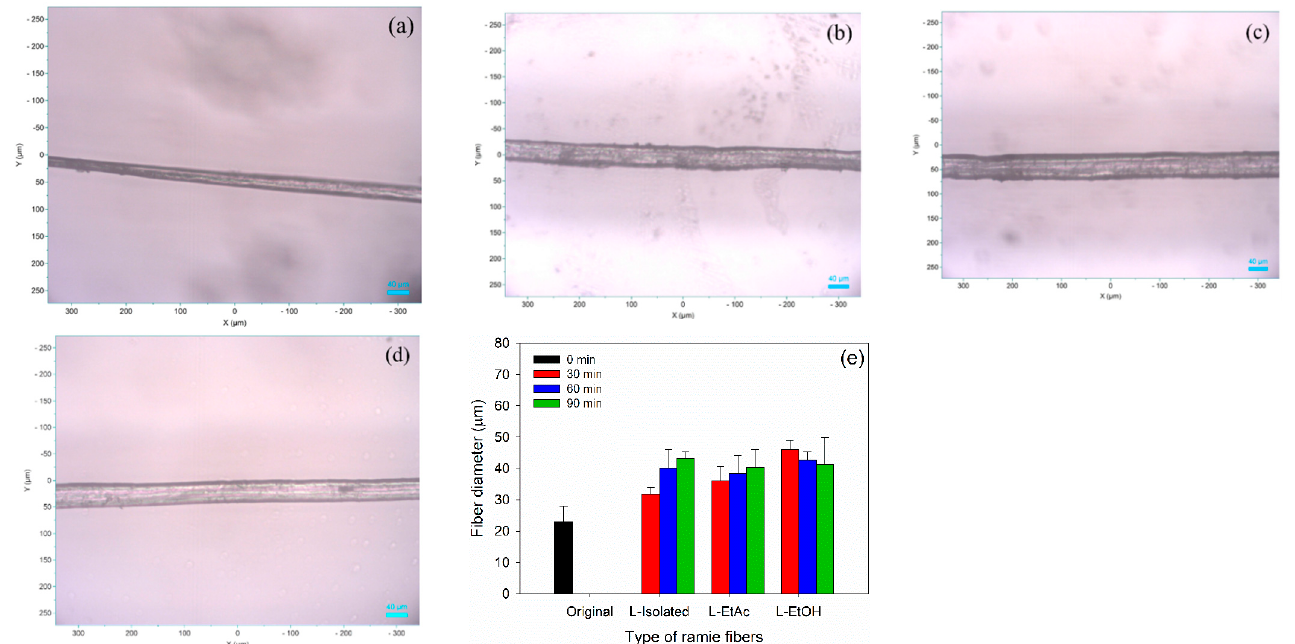
Figure 5. Typical microscopy analysis of ramie fibers before and after impregnation at 10× magnifi- cation: ( a ) original ramie fibers, ( b ) ramie–L-isolated—90 min, ( c ) ramie–L-EtAc—90 min, ( d ) ramie– L-EtOH—90 min, ( e ) average diameter of ramie fiber.